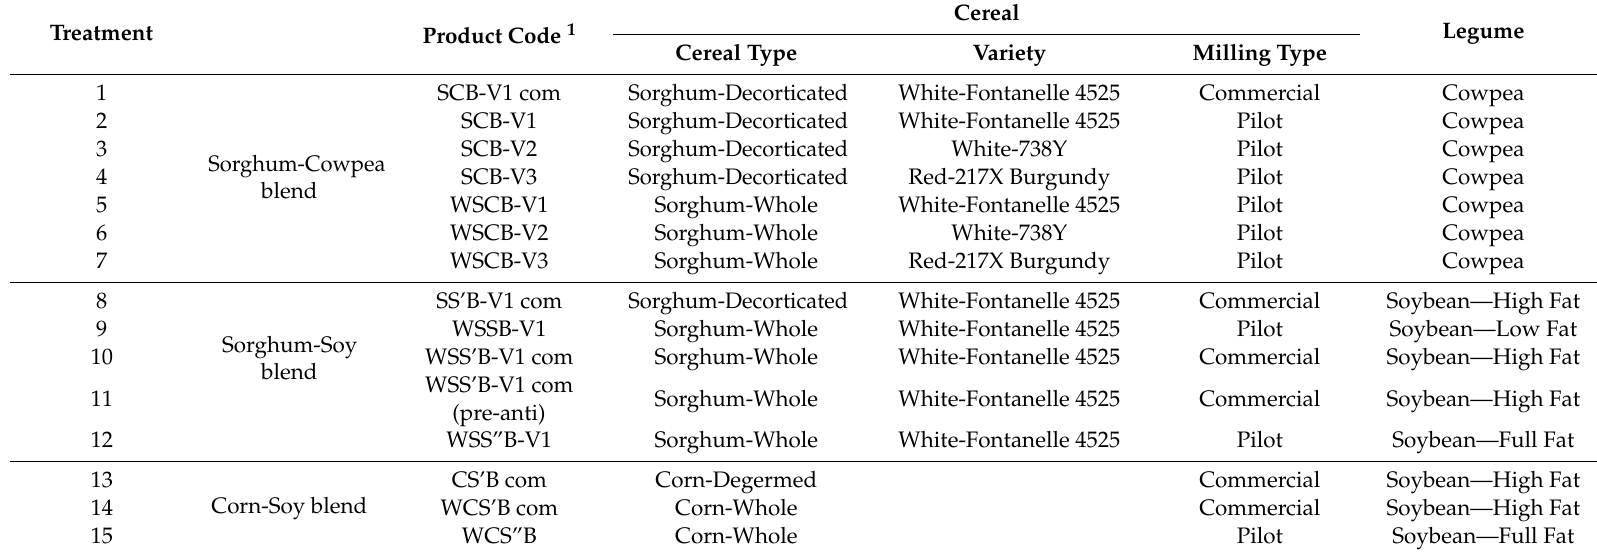
Table 1. List of processing and ingredients used for each extruded fortified blended food (FBF).